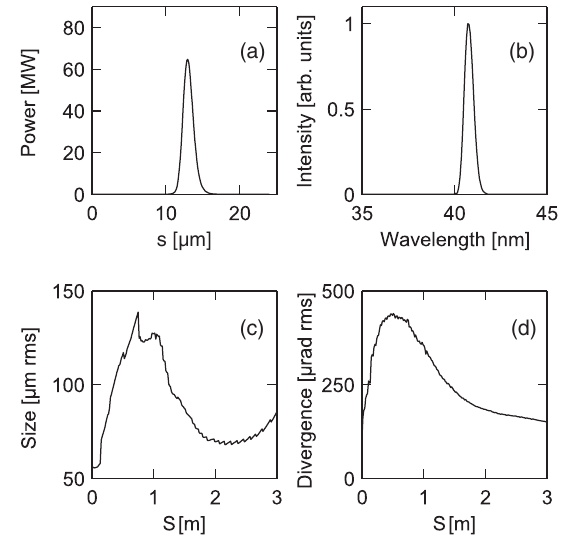
FIG. 19. FEL (a) peak power longitudinal profile and (b) spectrum at the undulator exit. FEL (c) transverse size and (d) divergence along the undulator. FEL radiation at 40 nm in optimum case of Fig. 18 ( r 11 ¼ r 33 ¼ 15 and r 56 ¼ 0 . 25 mm). Beam transport simulation in the nonlinear case with BETA and sympletic 6D tracking without collective effects using the S2I-CM optics. FEL simulation with